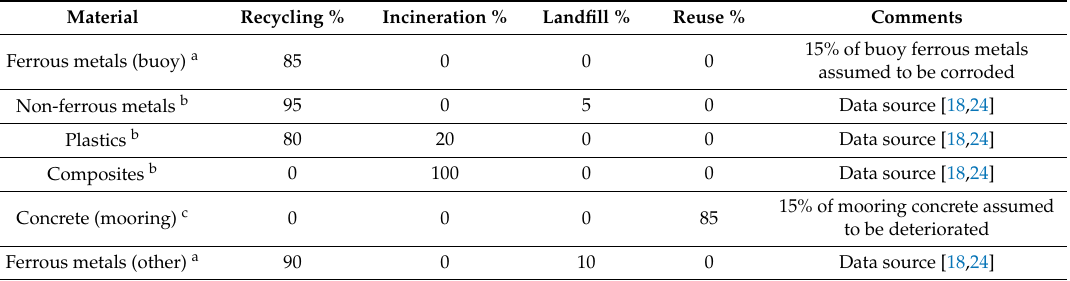
Table 3. Assumed waste routes at